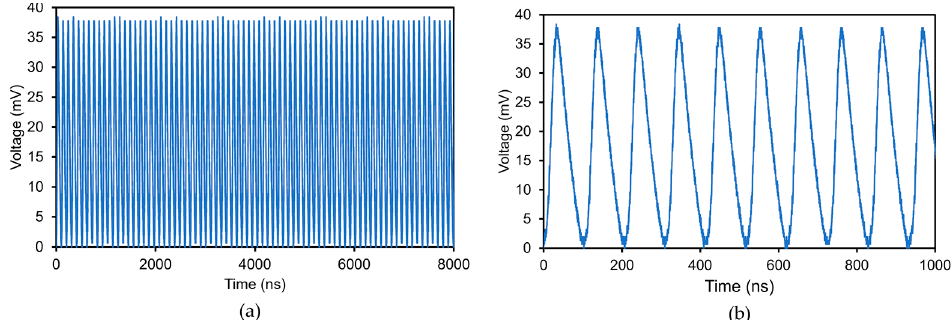
Figure 5. Typical temporal characteristics of the mode-locked YDFL: ( a ) zoom-out oscillation trace at the pump power of 203.5 mW and ( b ) zoom-in oscillation trace showing the separation between oscillation trace.